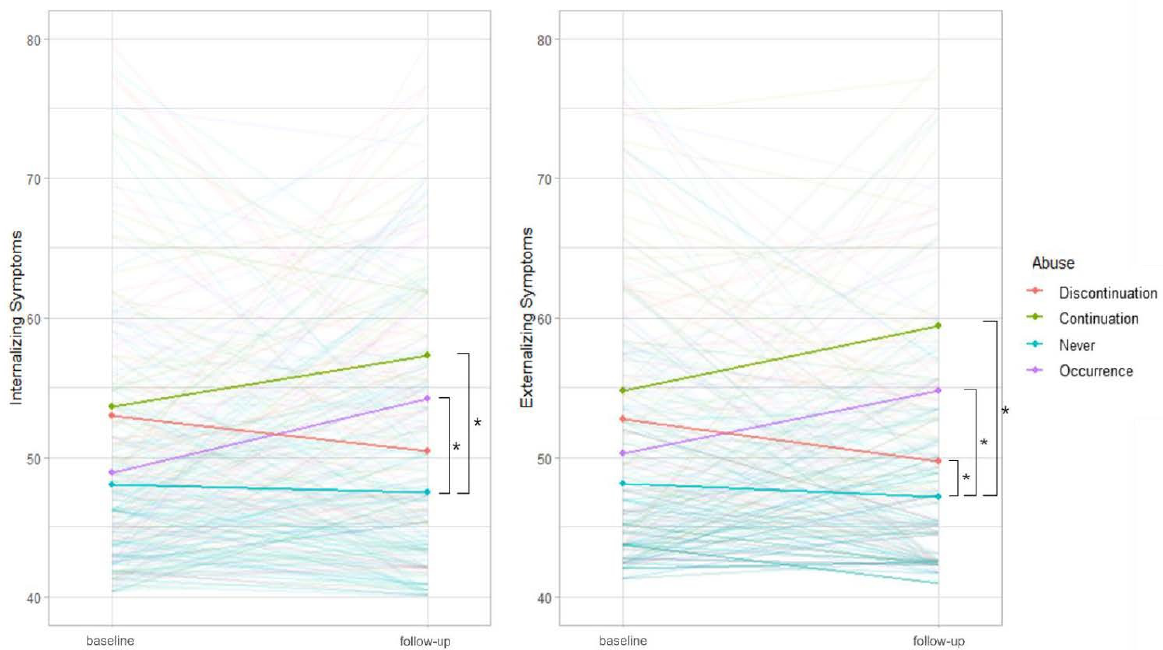
Figure 1. Effect of variation of abuse on internalizing/externalizing symptoms at follow-up. *: Significant relative risk. At baseline, the risk of psychopathology in the Continuation and Occurrence groups significantly increased. The K-CBCL score in the Discontinuation group decreased. Compared to those in the Never group, the internalizing symptoms of the Discontinuation group were no longer significant. Externalizing symptoms decreased, but remained significant.